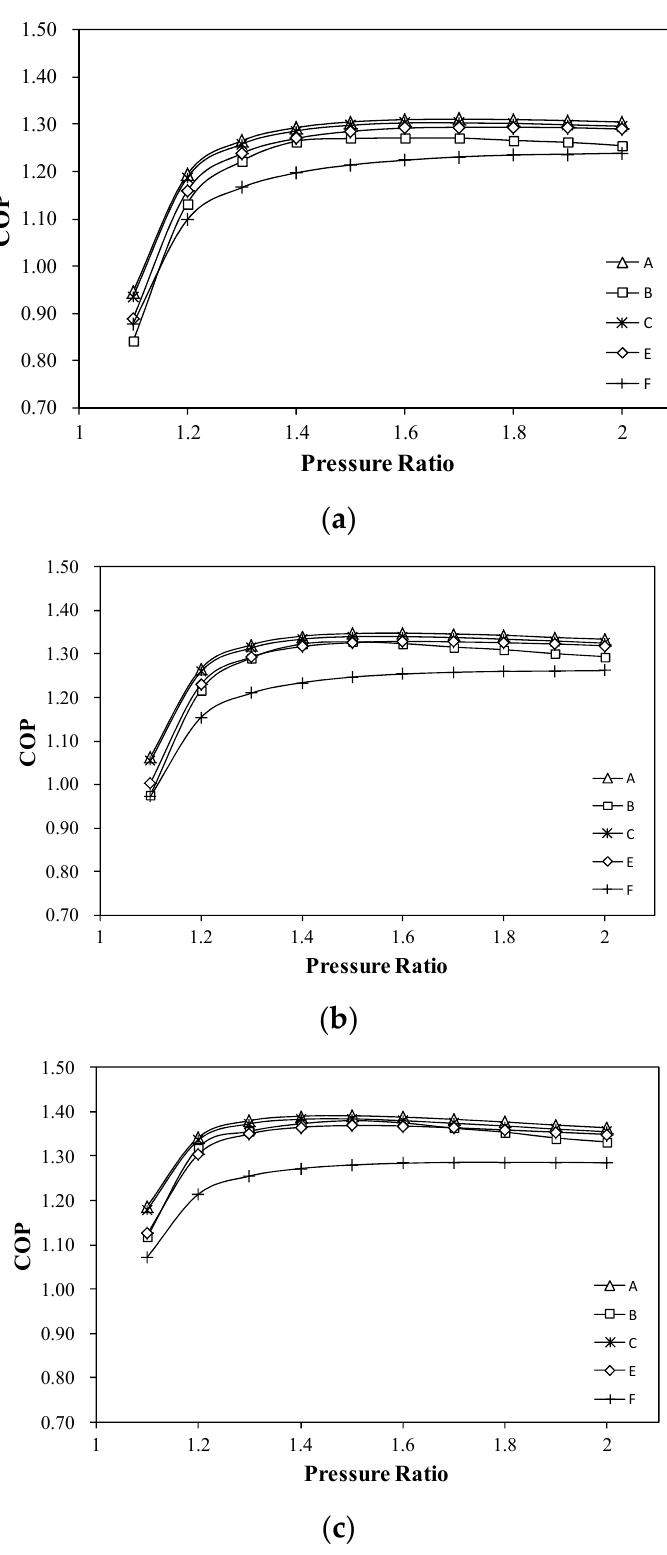
Figure 4. Variation of COP versus pressure ratio at 35 ◦ C hot water temperature. ( a ) Ambient temperature of − 15 ◦ C. ( b ) Ambient temperature of − 5 ◦ C. ( c ) Ambient temperature of 5 ◦